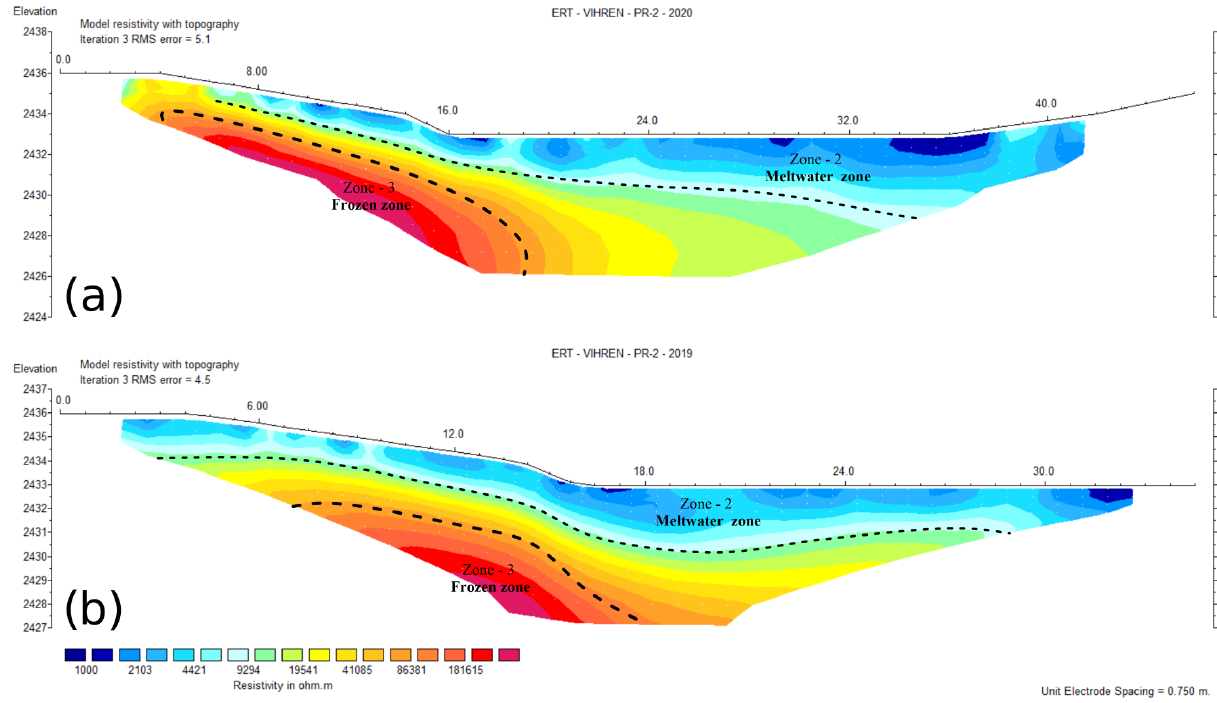
Figure 7. Electrical resistivity sections along ERT-2 obtained in the Golyam Kazan area in 2020 (a) and 2019 (b) .